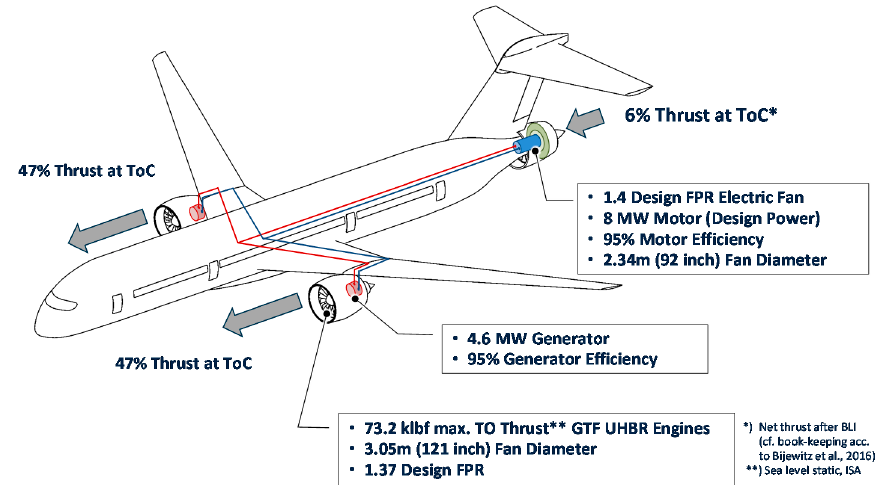
Figure 4. Main design features of the CENTRELINE initial propulsive fuselage target design (adapted from